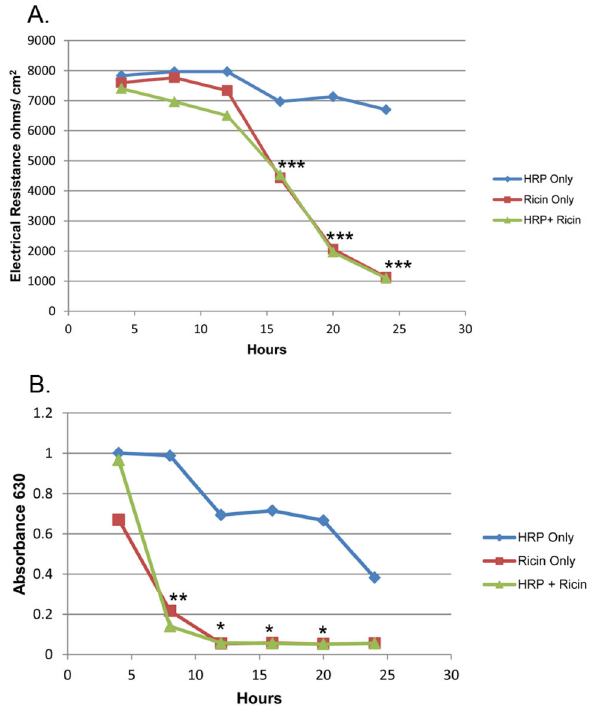
Figure 1. HCT-8 cells remain polarized after exposure to ricin for at least 16 hours. A . Transepithelial cell resistance (TEER) as a marker for cell polarization in transwell-cultured HCT-8 monolayers. TEER of 2000 ohms/cm 2 is considered indicative of polarization [11]. Resistance is shown at 0, 4, 8, 12, 16, 20, and 24 hours after administration of 3 µg/ml ricin (□), HRP (◊), or HRP + Ricin (Δ). B . Samples of media were